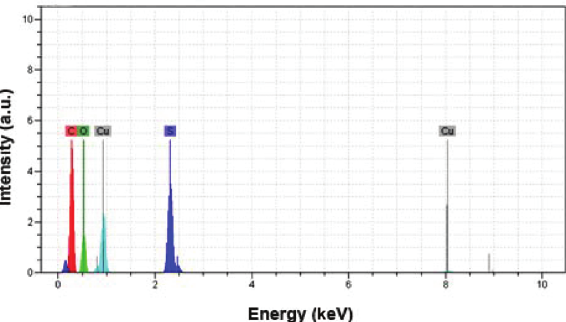
Figure 7: EDX pattern of posnjakite nanoparticles.